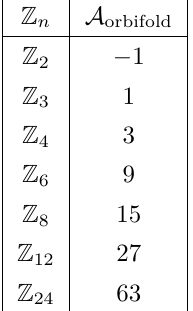
Table 8 . The additional gravitational anomaly contribution from C 4 / Z n orbifold singularity on a compact singular